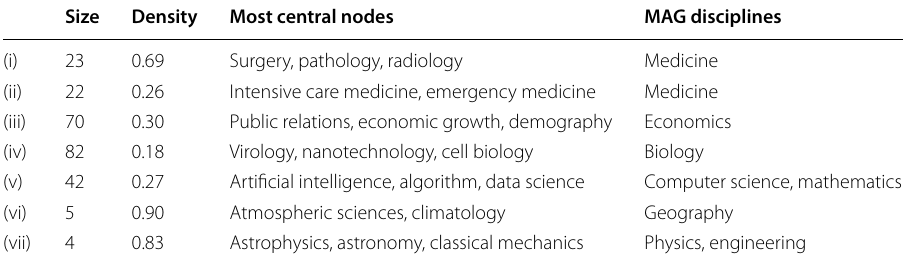
The predominant roles discussed in the text are highlighted in bold Table 4 Louvain communities in COVID-19-related research and their size, network density, most central topics (according to degree centrality) and the most frequent MAG disciplines that are identified in them ( ≥ 10% of